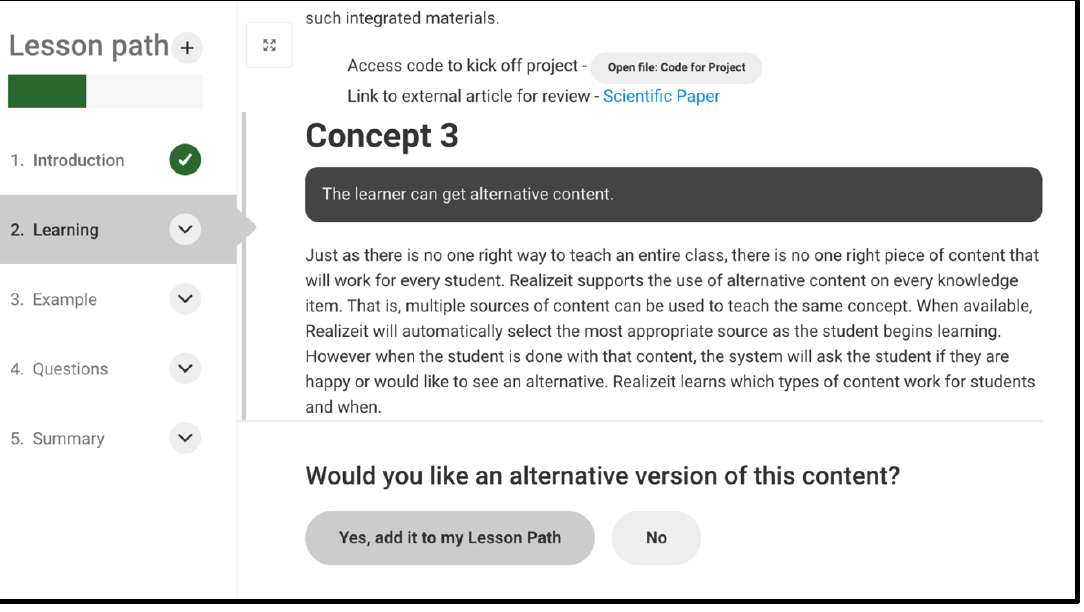
Figure 6. An example of a Realizeit lesson with alternative